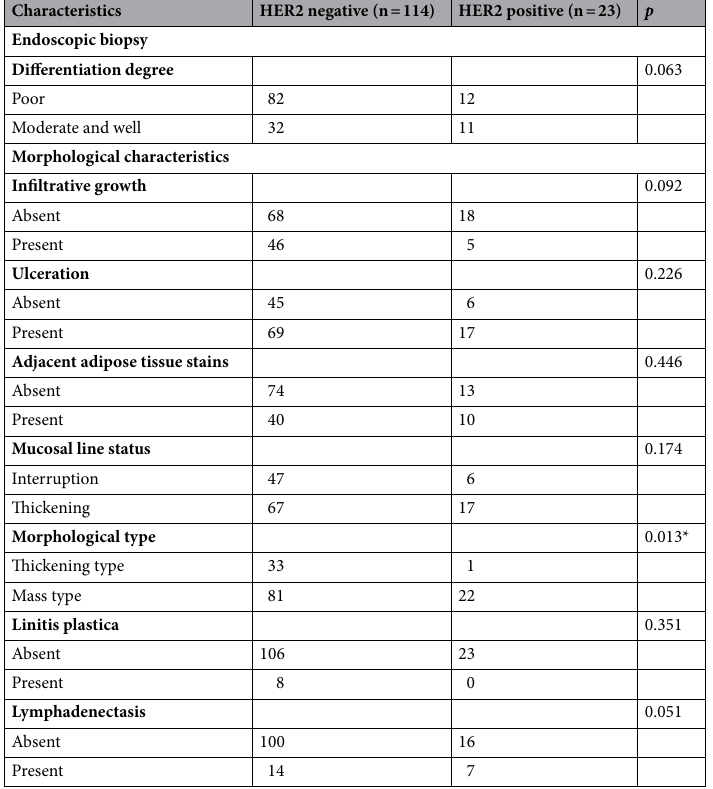
Table 2. Univariate analysis of endoscopic biopsy and morphological characteristics in the primary cohort. HER2 human epidermal growth factor receptor 2; * p < 0.05 with chi-square test or Fisher’s exact test (n <